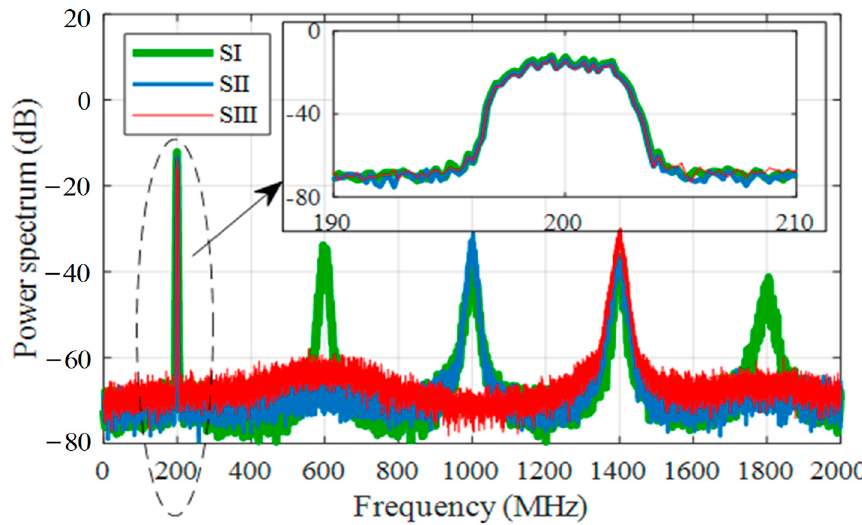
Figure 8. Simulated spectrum of the proposed method for the 16QAM input signal at 200 MHz car- rier with T r = 1%.